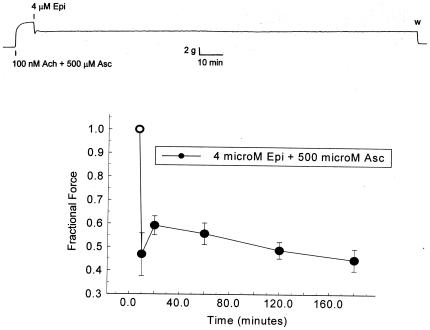
Effect of 500 µM ascorbate on prolonged 4 µM epinephrine relaxation of 100 nM Ach contraction of porcine trachealis.Upper panel: chart record of experiment. Lower panel: Values are mean ± SE. The open symbol is the relative force immediately prior to the introduction of Epi and Asc. The closed symbols represent values at different times after the introduction of Epi and Asc.